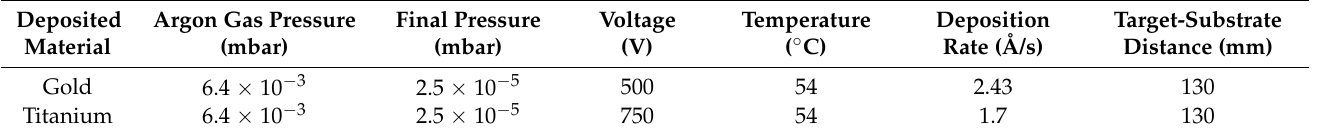
Table 1. Data of materials deposition by the magnetron sputtering method on the AFM tips.